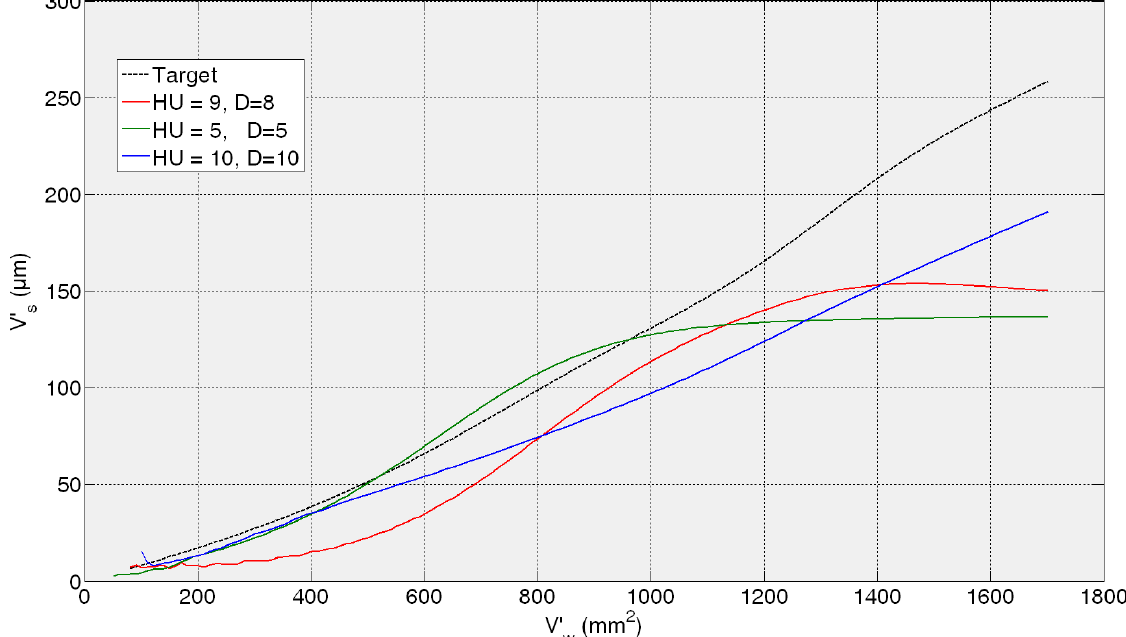
Figure 10. Generalization capability of the three preselected configurations . Test experiment : 82AA36G6VW q = 60; Q' = s